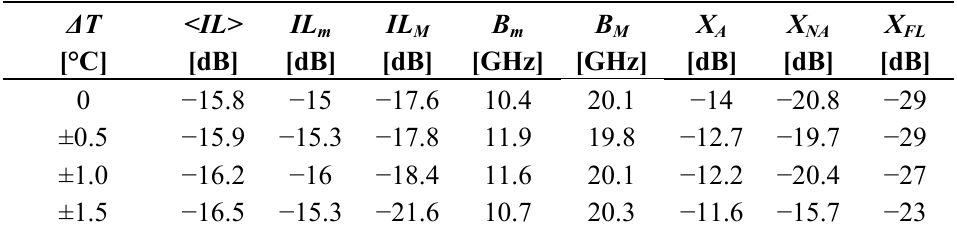
Table 3. Resonance frequency drifting, 32@50